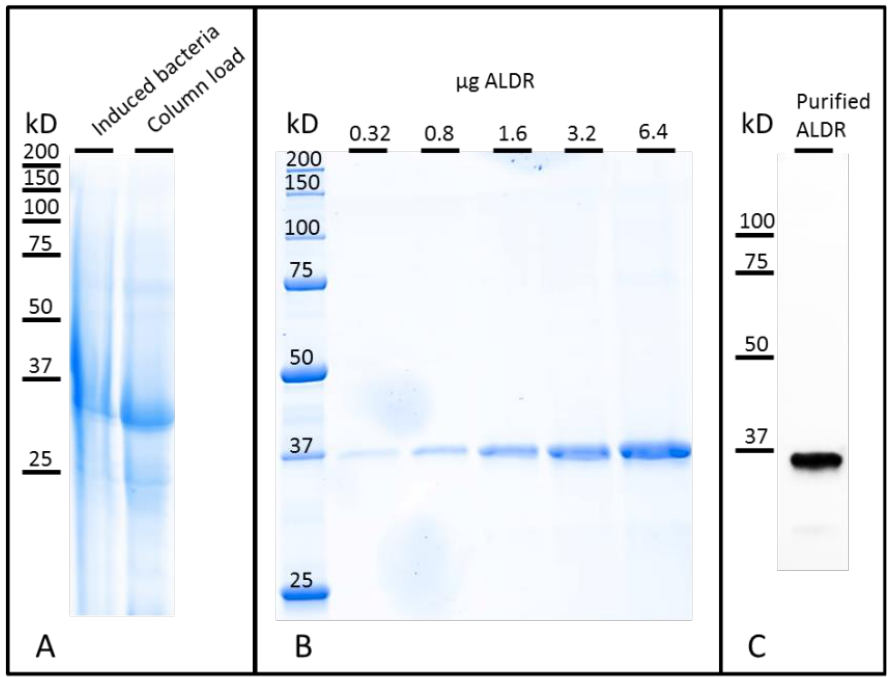
Figure 2. ALDR electrophoresis analysis. ( A ) Total protein before purification (CBB). ( B ) Observa- tion of different quantities of purified ALDR (CBB). ( C ) Visualization of the purified ALDR using western blotting.